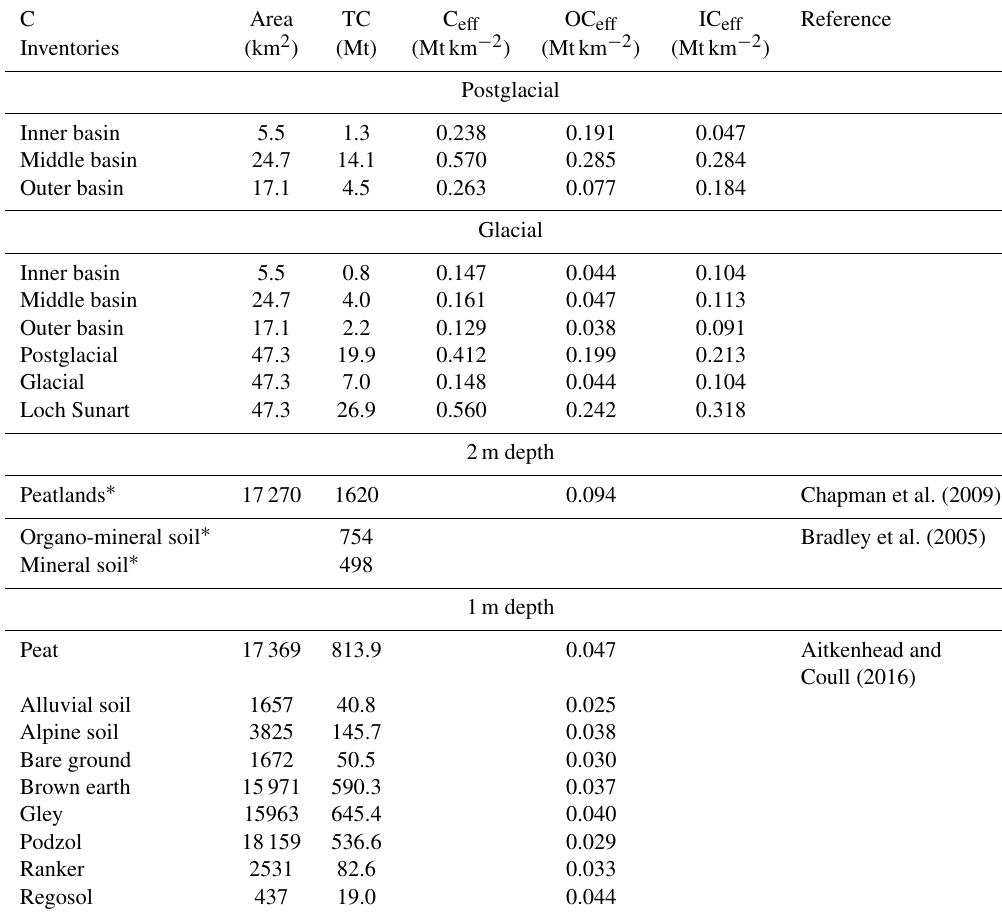
Table 5. The effective C storage (C eff ) of Loch Sunart’s postglacial and glacial sediment in comparison to Scottish terrestrial C stores. C Area TC C eff OC eff IC eff